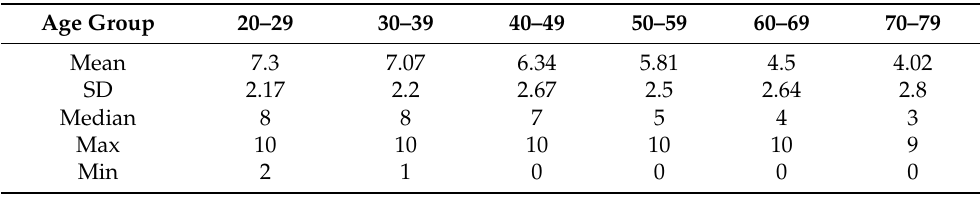
Table 2. Descriptive results of accuracy on the GVT test separated for decades of age.